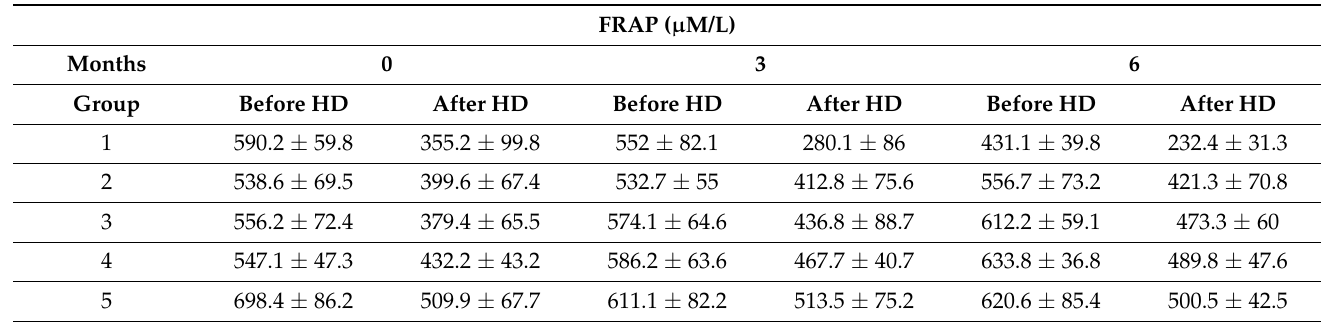
Table 5. Comparison of serum FRAP antioxidant activity ( µ M/L) between groups before and after HD during 6 months of the study.